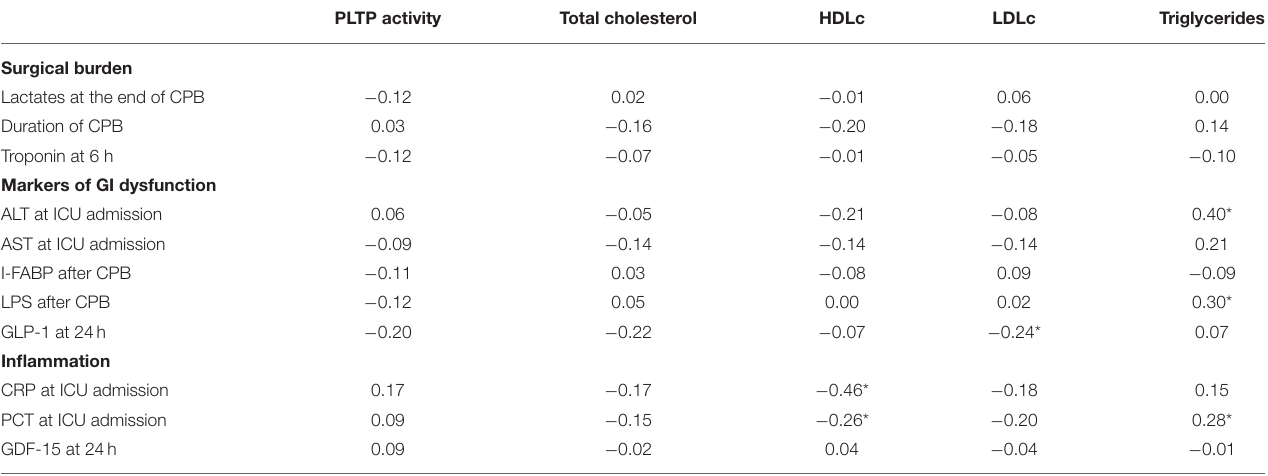
TABLE 3 | Association between lipid parameters and secondary